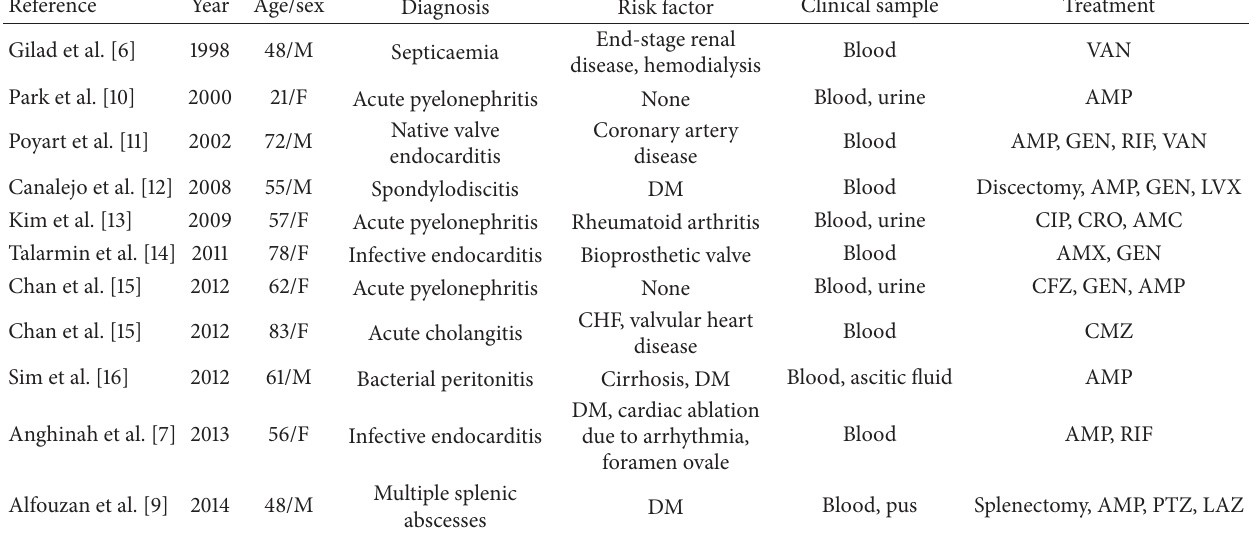
Table 1: Reported cases of human infections due to E. hirae . Adapted from Alfouzan et al. [9]. AMC, amoxicillin-clavulanic acid; AMP, ampicillin; AMX, amoxicillin; CFZ, cefazolin; CHF, congestive heart failure; CIP, ciprofloxacin; CMZ, cefmetazole; CRO,